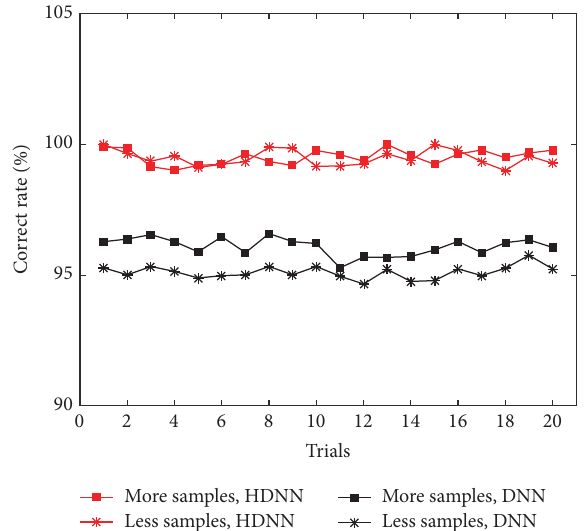
Figure 11: Robustness of the fault classification method to the sample number of training data with 20